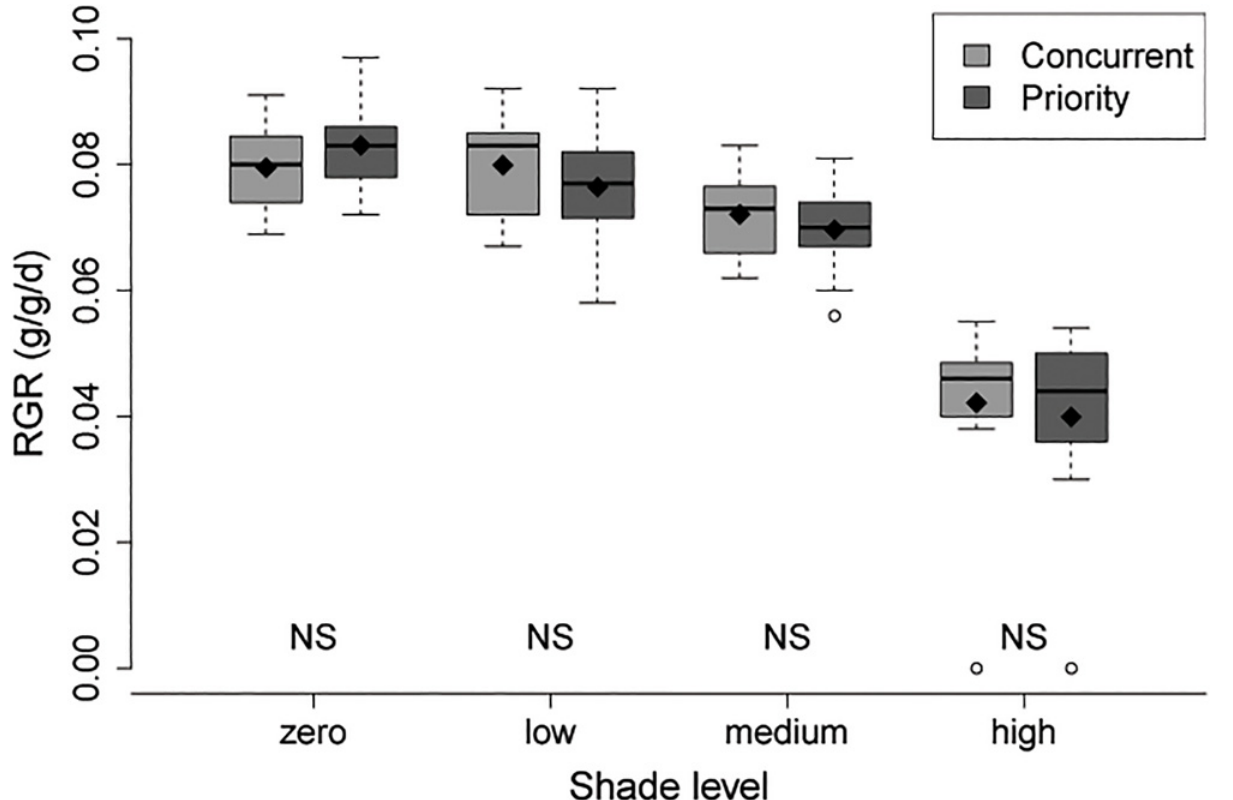
Fig 4. Boxplots comparing M . spicatum RGR in the concurrent and priority treatments across shade levels. Box edges mark the 1st and 3 rd quartile, and the median is shown with a dark line. Whiskers extend to a maximum of 1.5 x interquartile range outward, and values beyond this are indicated by circles. Diamonds show means of each competition treatment * shade level combination. “ NS ” indicates non-significant differences in pairwise t-tests between competition treatments.